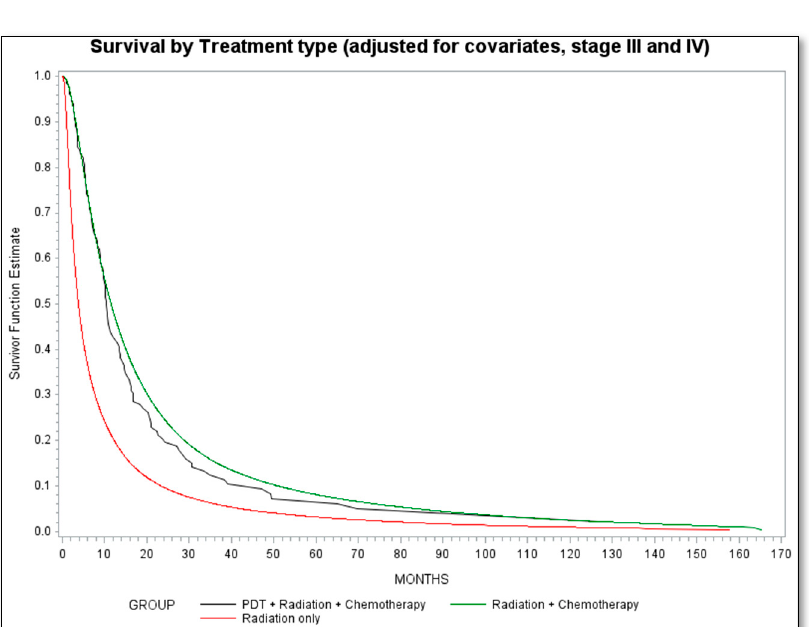
Figure 1. Survival by treatment type adjusted for covariates, stage III and IV NSCLC. Radiation is reference category.